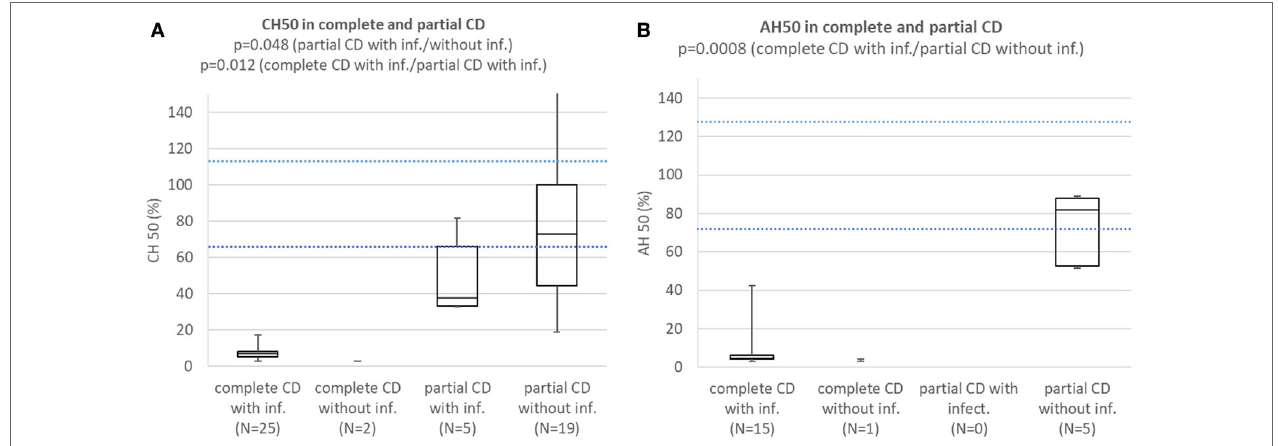
FigUre 3 | (a) Comparison of CH50 between patients with complete CD with infections, complete CD without infections, patients with partial CD with infections, and subjects with partial CD without infections. Patients with hereditary angioedema (HAE) and properdin deficiency are excluded. (B) Comparison of AH50 between patients with complete CD with infections, complete CD without infections, patients with partial CD with infections, and subjects with partial CD without infections. Patients with HAE and CD not affecting AH50 are